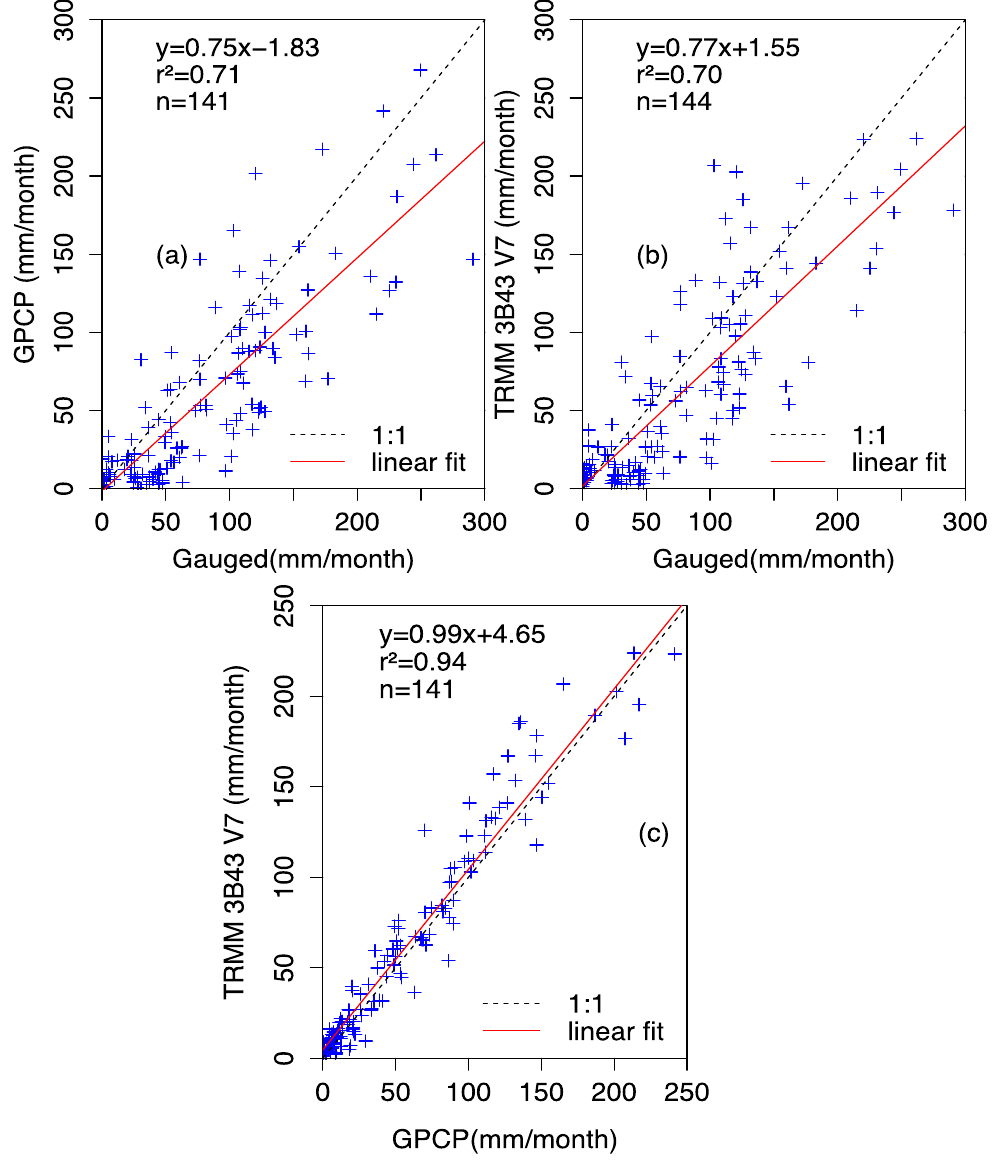
Figure 4. ( a ) Comparison of GPCP precipitation and rain gauge data; ( b ) TRMM 3B43 V7 accumulated precipitation and rain gauge data; ( c ) GPCP as related to TRMM 3B43 V7 precipitation